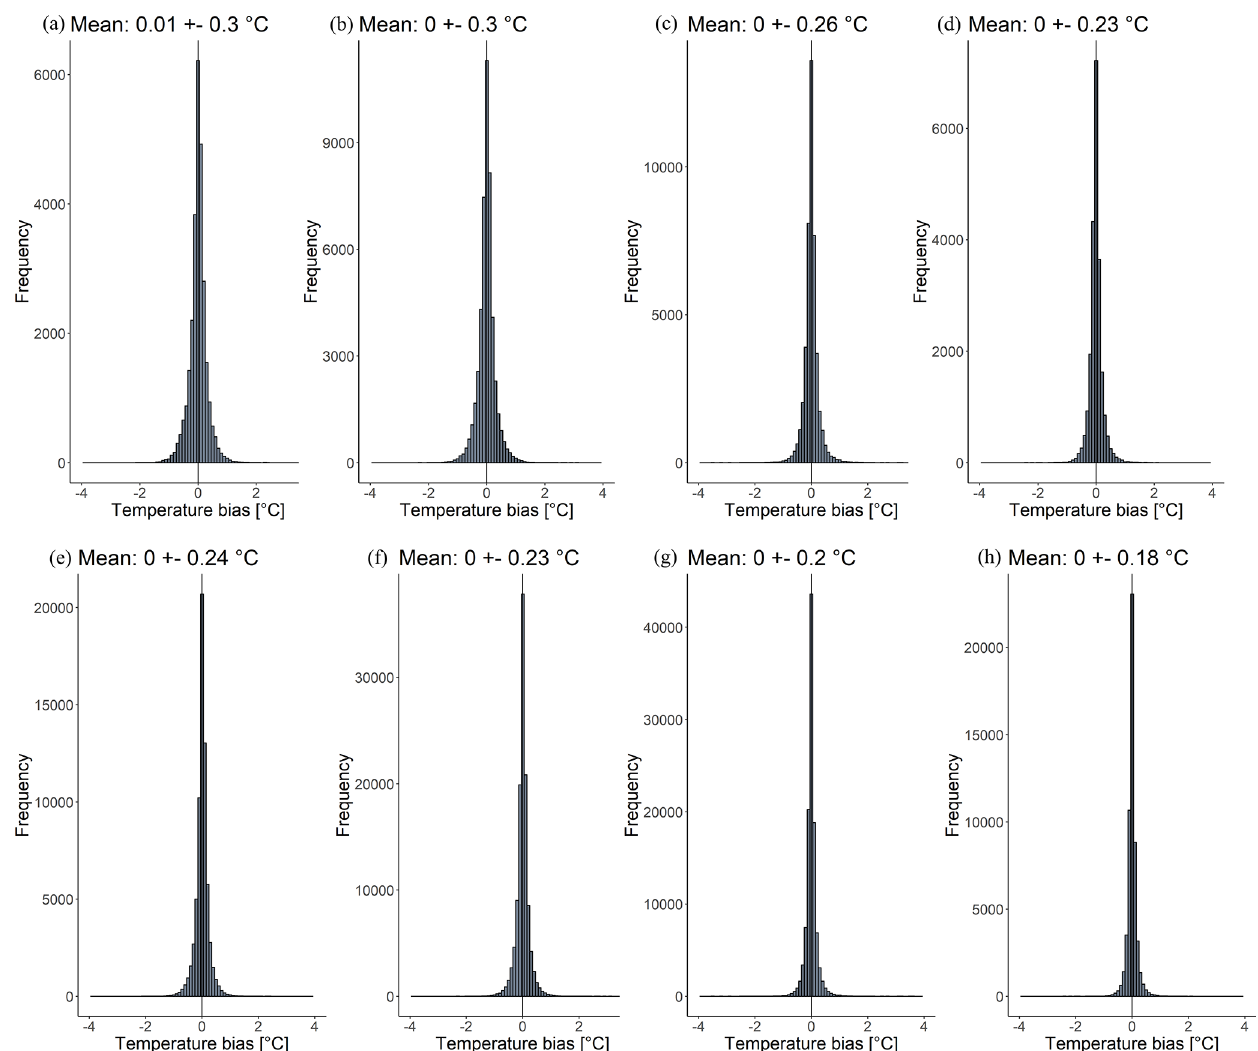
Figure D1. Same as Fig. 9 but for QC level 3. Comparison between (cid:49)T for the test dataset (a–d) and (cid:49)T for the complete dataset (e–h) .